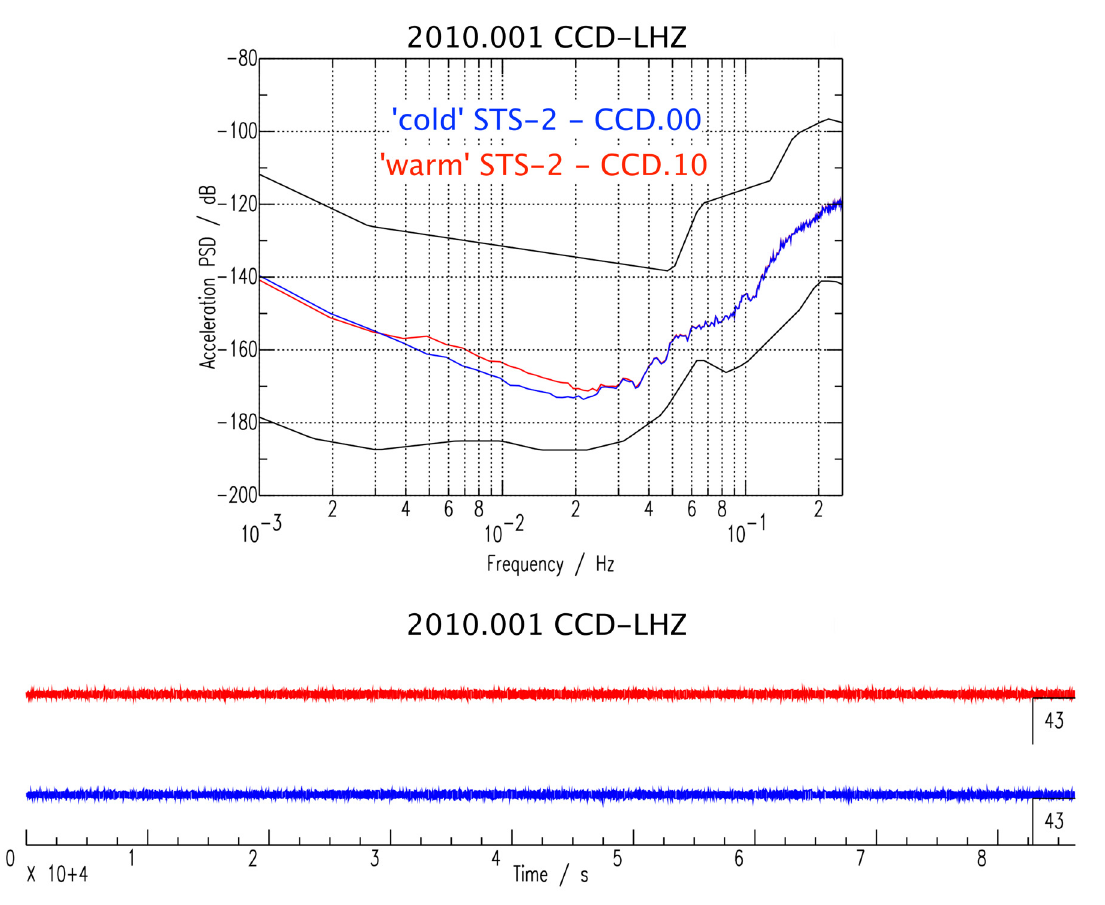
Figure 1. One-day power spectral density plot for CCD station (vertical component, 1sps data) on January 1st, 2010. Also shown are the seis- mograms for the same day. We run two parallel instruments at Dome-C to ensure redundancy. On January 1st, 2010, these were two STS-2 seis- mometers, one kept at ambient temperature (–54°C, blue lines, locid 00) recorded on a Quanterra Q330 digitizer, and one heated to –30°C (red lines, locid 10) recorded on a Quanterra